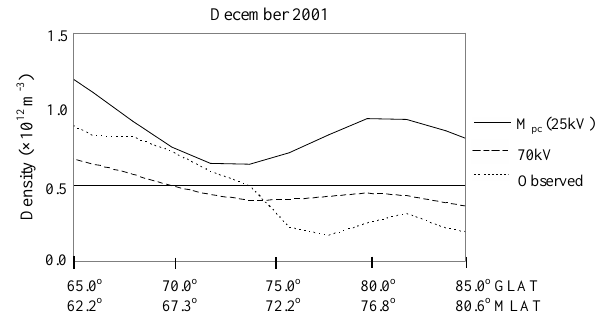
Fig. 7. Ionisation densities from the CTIP model at 18 ◦ E and al- titude of 260km at 11:00 UT from the model run M pc with cross- polar potential of about 25kV (solid curve) and identical model run but with an electric potential pattern with a cross-polar potential of about 70kV (long dashed curve). Also shown are the corresponding median electron densities from the tomography observations aver- aged over 2 ◦ latitude (short dashed